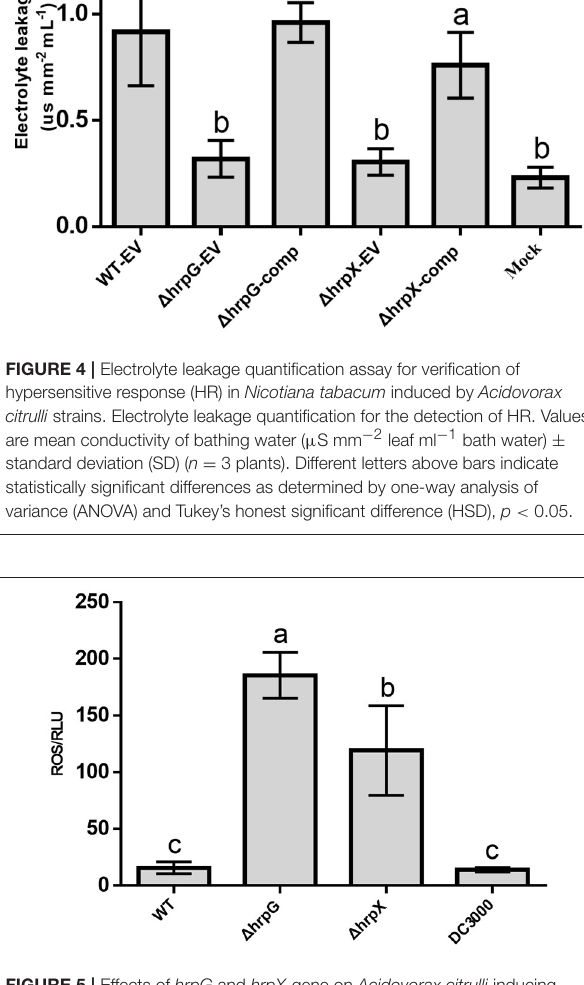
FIGURE 5 | Effects of hrpG and hrpX gene on Acidovorax citrulli inducing ROS on Nicotiana benthamiana . Reactive oxygen species (ROS) generation by the wild-type A. citrulli strain Aac5 and the hrpG and hrpX deletion mutants. ROS assay results are presented as mean and standard deviations based on three replicates from three different plants. Different letters above bars indicate statistically significant differences as determined by one-way analysis of variance (ANOVA) and Tukey’s honest significant difference (HSD), p < 0.05.